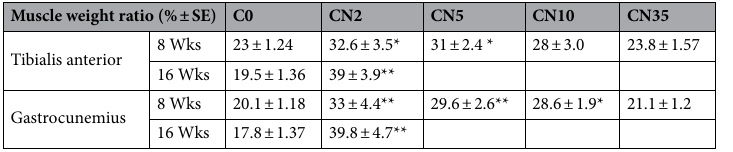
Table 2. Lower limb muscle weight ratio for the five test groups at 8 and 16 weeks after transplantation. *P < 0.05; **P < 0.01 (One-tailed ANOVA with Tukey–Kramer test (8 weeks) and Student t-test (16 weeks) compared with C0).